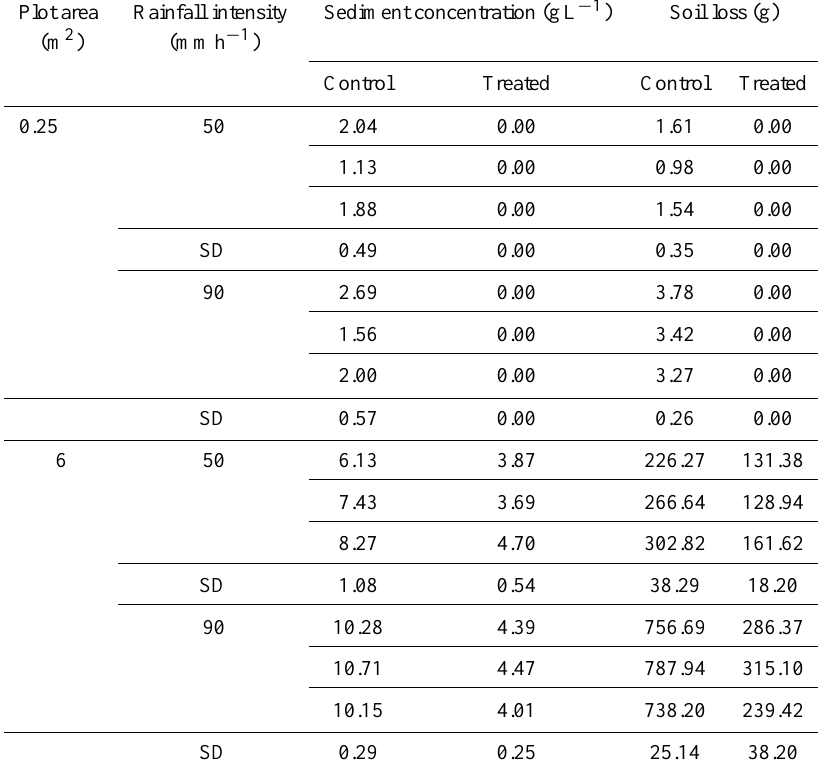
Table 3. Sediment concentration and soil loss measured at the outlet of the study plots before and after applying conservation treatment.